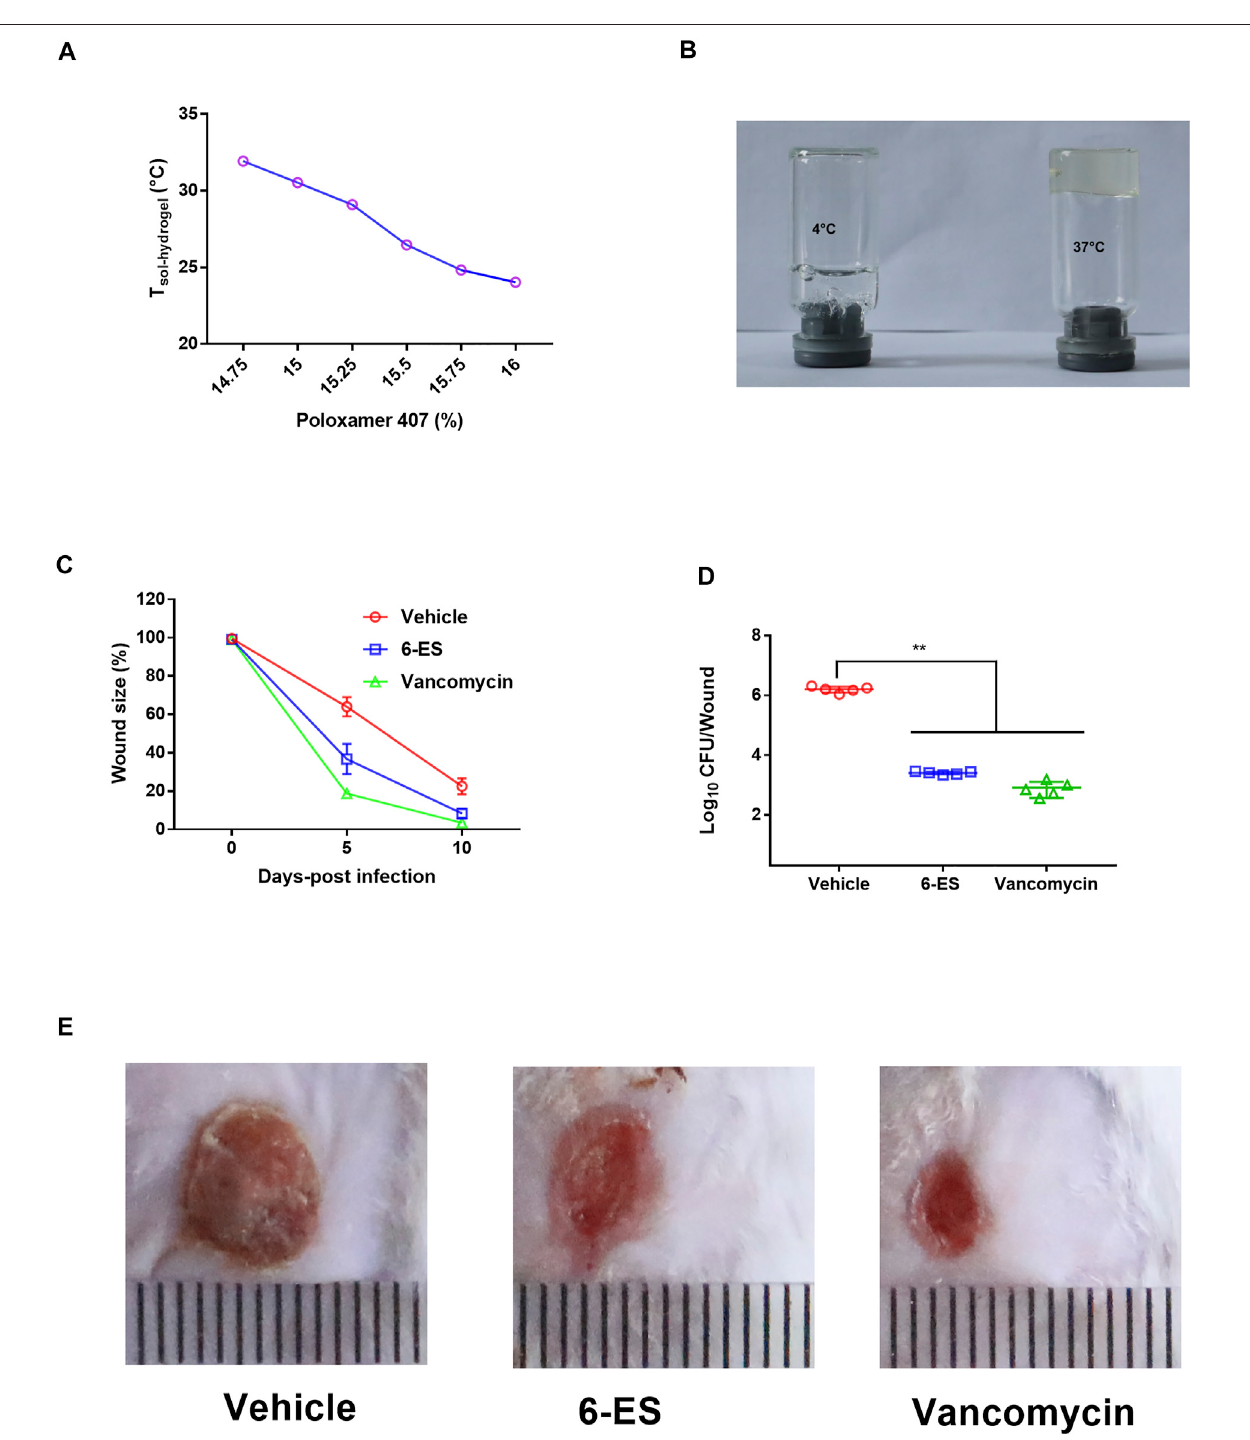
FIGURE5| 6-EShydrogelpromotedwoundhealinginmiceinfectedwithMRSA. (A) T sol – hydrogel of6-ES-loadedhydrogelwithdifferentconcentrationsofP407. (B) Digital pictures of6-ES hydrogel at 4 and 37 ° C. (C – E) Wound sizes, bacterial burdens, and images ofMRSA T144-infected wounds in mice treated with 6-ES hydrogel, vancomycin hydrogel, or vehicle hydrogel.